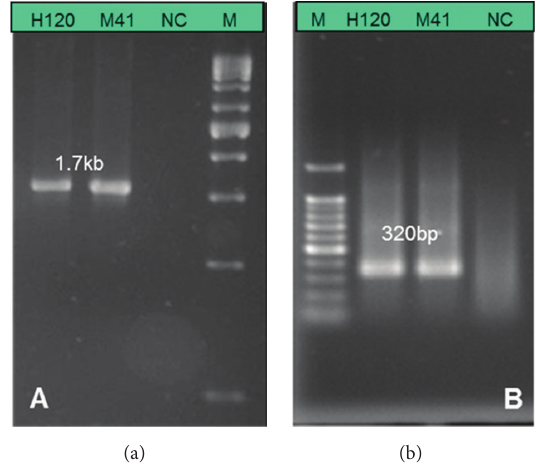
Figure 10: Electropherogram showing 1.7 kb RT-PCR amplified S1 genes from vaccine (H120) and virulent (M41) IBV strains (a) compared to a 320 bp RT-PCR amplified N-gene (b) of H120 and M41 IBV serotypes. Lane M = 1 kb molecular ladder (a) and 100 bp ladder (b); lane NC: negative control (no template